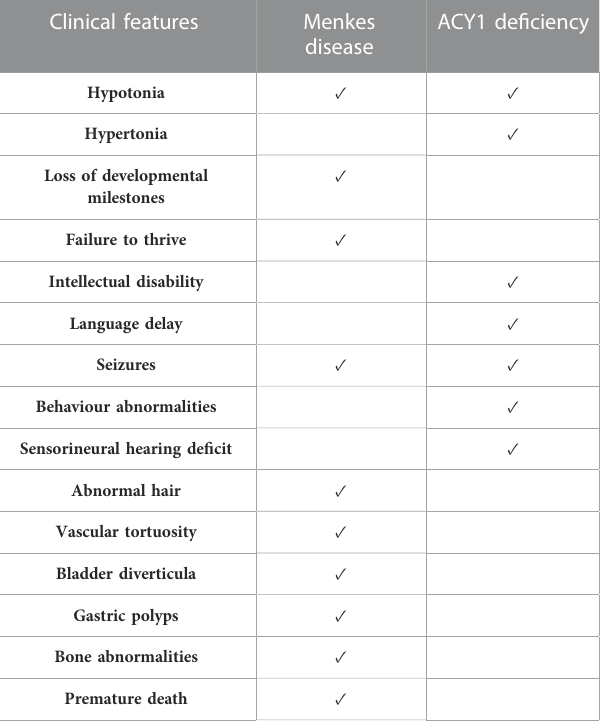
TABLE 1 Overview of the symptoms in the proband and the most commonly reported phenotypes of both conditions. Clinical